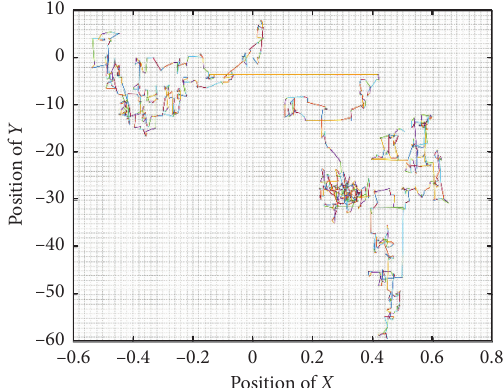
Figure 7: Particle flight path in two-dimensional space.